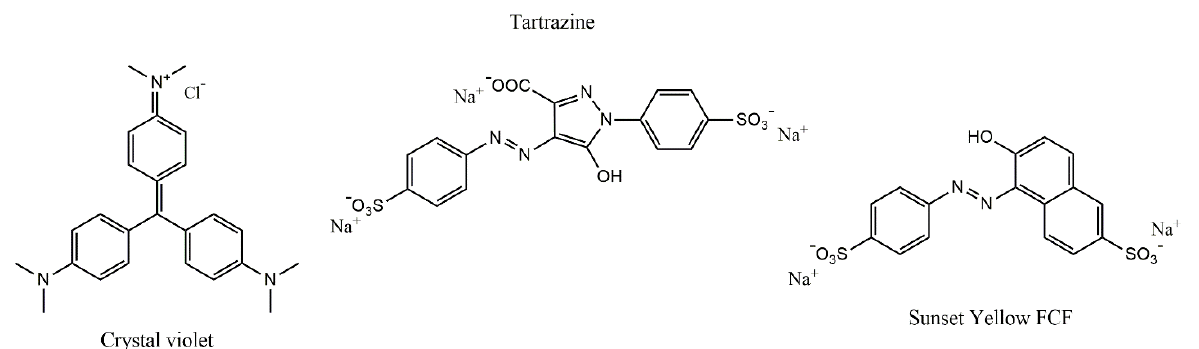
Figure 1. The molecular structures of